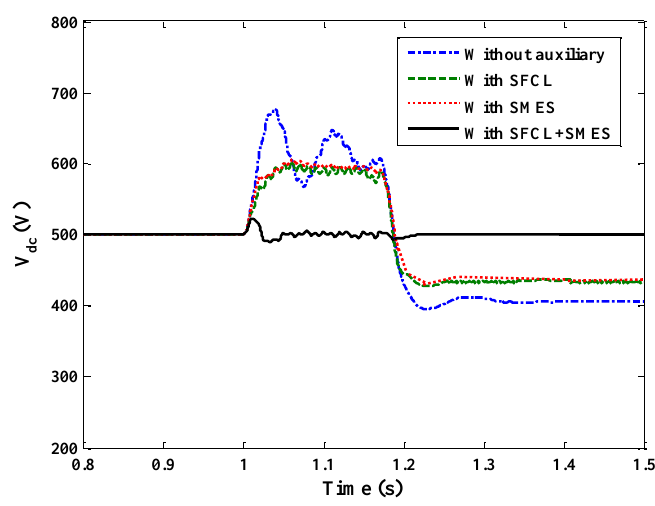
asymmetrical fault. ( a ) A-phase voltage; ( b ) B-phase voltage; and ( c ) C-phase voltage.